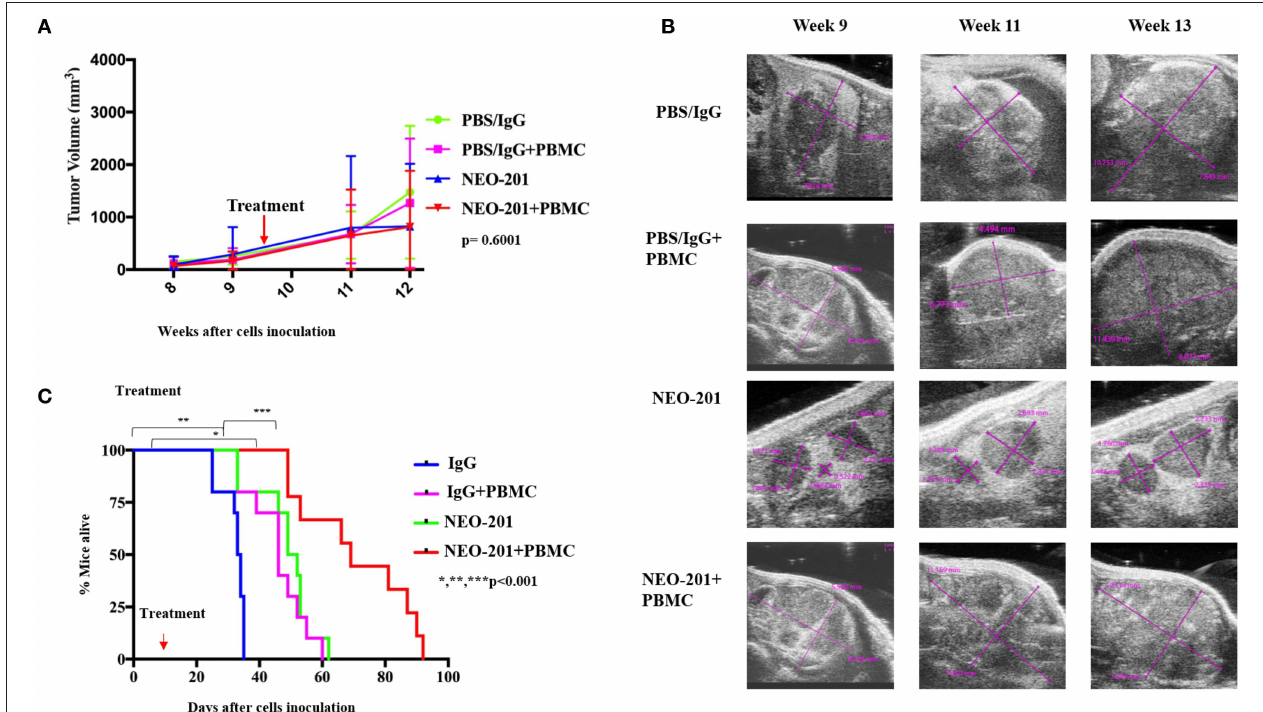
FIGURE 4 | Antiproliferative response to NEO-201 and survival in model of ovarian cancer in vivo . (A) OV90 cells were injected in the mice ovary bursa and observed for their ability to develop tumors. Tumors were allowed to grow until they reached at least 100 mm 3 , about 8 weeks post cell injection. Tumor size was followed by weekly ultrasound. After randomization, each mouse received one cycle of treatment, which consists of two doses of drug on day 1 and day 7 of week 10. Curves represent tumor volume when treated × 3 with either control {phosphate-buffered saline (PBS)/IgG}, PBMCs (8 million cultured in 200 U/ml IL2 overnight), NEO-201 (250 µ g), or their combinations. Kruskal–Wallis test was used to evaluate significance ( p = 0.6001). (B) Representative ultrasound images of tumor-bearing mouse ovaries. Purple lines indicate cross sectional measurements from which volume was calculated. (C) OV90 cells were injected in the mice peritoneum to reproduce an orthotopic model of peritoneal carcinomatosis from ovarian cancer spreading. Tumors were allowed to grow for 2 weeks before being randomized in the four groups of treatment as described above. Curves represent survival. Significance was evaluated by Mantel–Cox. * P < 0.05, ** P < 0.01, *** P <